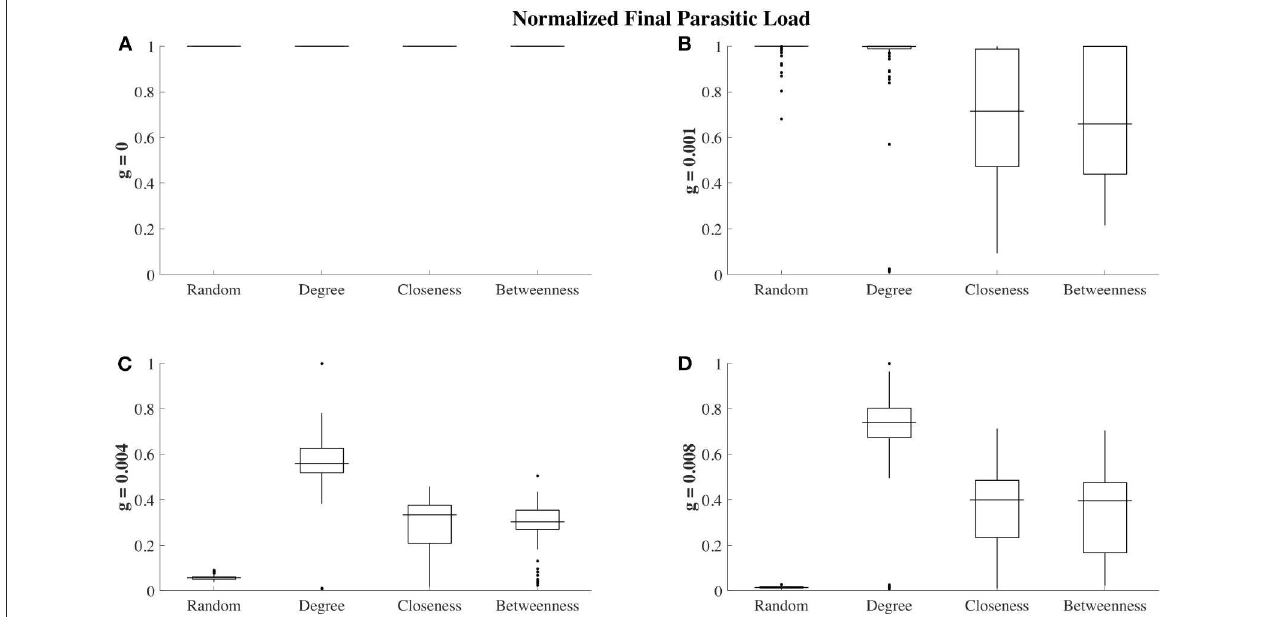
FIGURE 5 | Ectoparasite loads at t = 300 (150 steps after ectoparasite introduction) for different grooming efficiencies and social affiliation strategies. Each box plot shows ectoparasite load over 100 trials, where ectoparasite load has been re-scaled between 0 (no ectoparasites on any node) and 1 (maximum infestation observed for a given grooming efficiency). In the absence of grooming ( g = 0, A ), all 4 of the social affiliation strategies result in maximal ectoparasite load in all trials. For low grooming efficiencies ( g = 0.001, B ), closeness and betweenness affiliation strategies are more effective at reducing ectoparasite load. When grooming efficiency is increased to g = 0.004 (C) , the random affiliation strategy is most protective, followed by closeness and betweenness. The degree affiliation strategy is the least protective against ectoparasite infection load. We also observe this qualitative behavior when g = 0.008 (D)